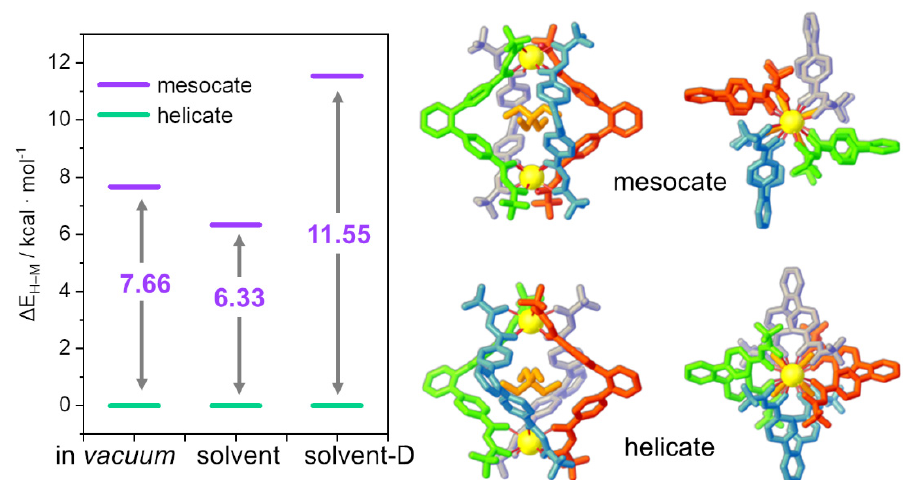
Figure 2. Energy difference between helicate and mesocate isomers ( Δ E H–M , kcal/mol) for the test system NEt 4 ⸦ C1 . Side and top views of the helicate (bottom) and mesocate (upper) isomers. However, even if all methods are almost equivalent to predicting the most stable iso- mer, their performances are strongly different when comparing the capability to repro- duce the geometrical and structural parameters of the NEt 4 ⸦ C1 cage. In order to deter- mine and quantify the methods’ accuracy, cage description was simplified to a pseudo- octahedron (Figure 3A), where the six vertices are the two La 3+ ions and the four centroids of the ligand central scaffold. Three different distances were defined (Figure 3B): (i) one along the axial direction connecting the two La 3+ ions (d La–La , blue dashed line); (ii) two on the equatorial plane, i.e., the distances connecting two opposite ligands’ spacer centroids (d opp , red dashed lines) and the distances of the equatorial side (d side , green dashed lines). For the equatorial plane distances (d opp and d side ), the average values were considered.